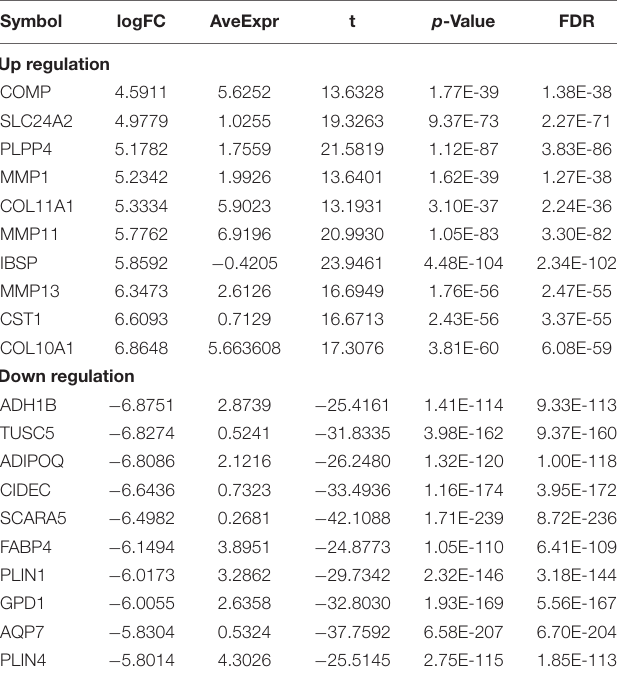
TABLE 4 | Top10 (up- and down-regulated) of differentially expressed miRNAs in normal tissues and breast cancer tissues. Symbol logFC AveExpr t PValue FDR